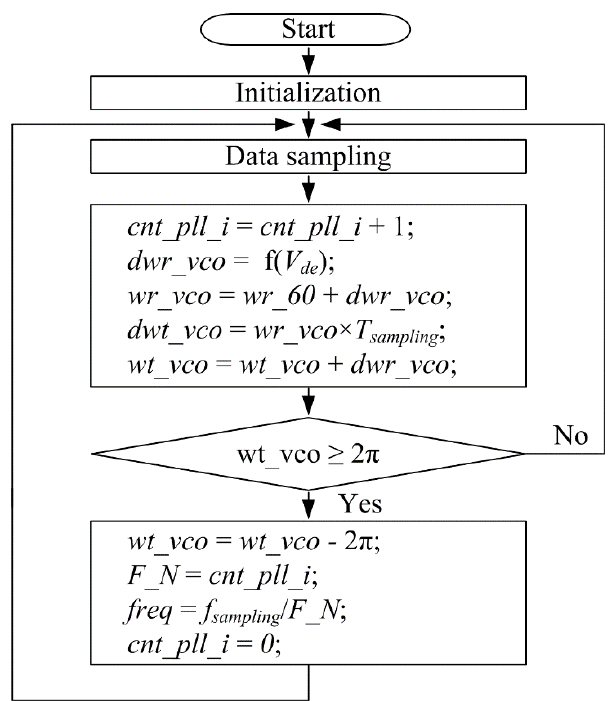
Figure 5. Flowchart of the conventional PLL technique to calculate the line frequency.